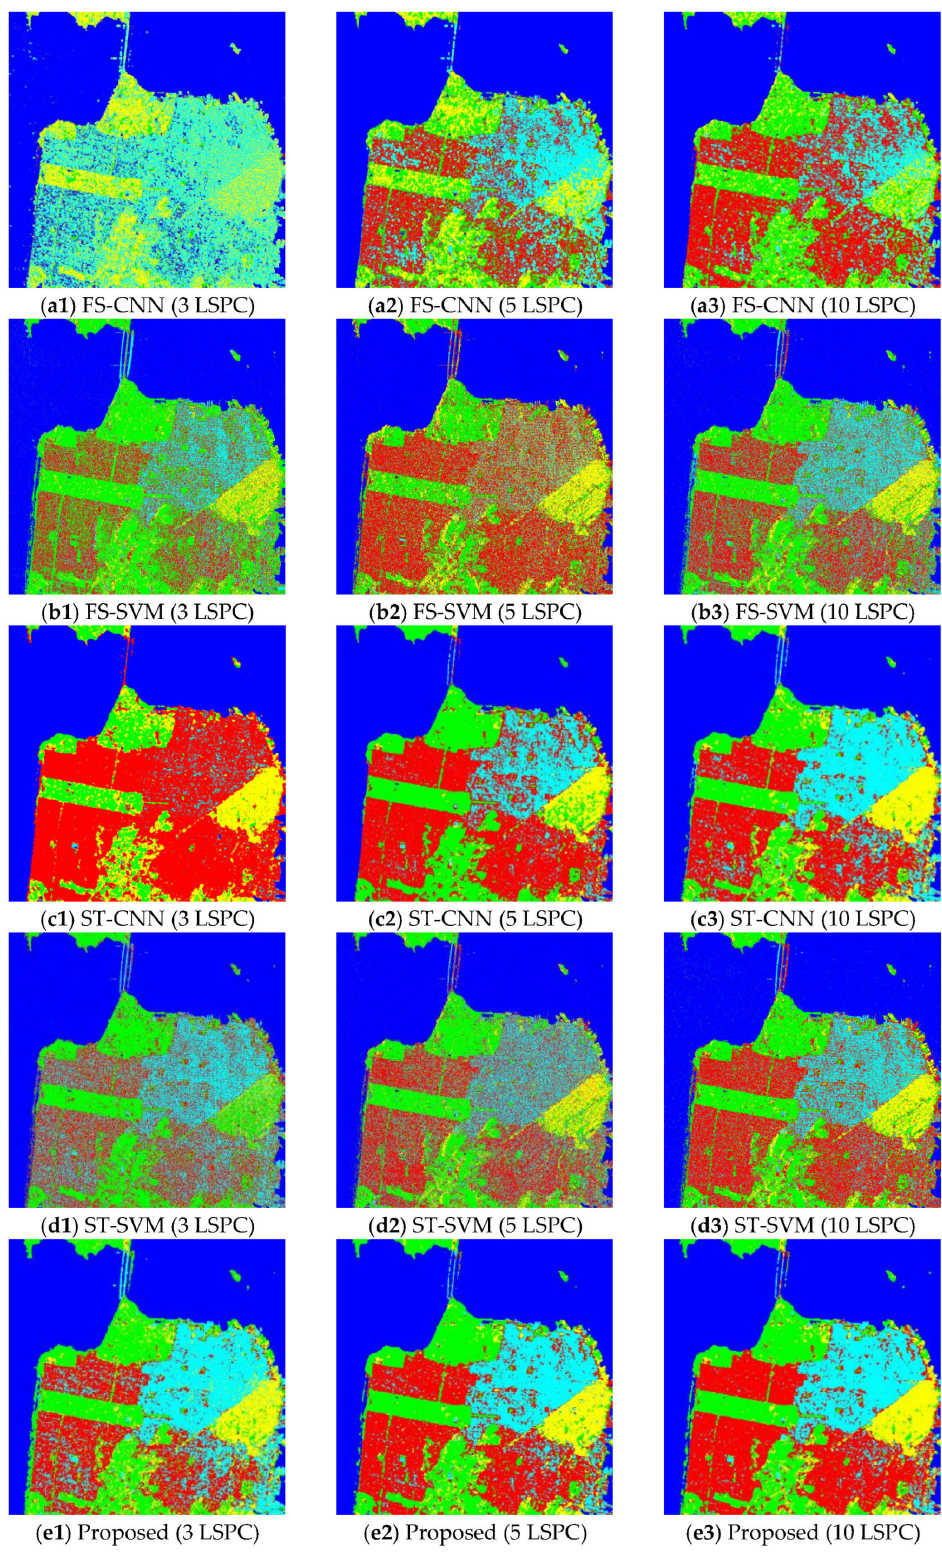
Figure 10. Classification maps of dataset 3 given by five methods with different sample sizes. The maps from up to down are given by FS-CNN, FS-SVM, ST-CNN, ST-SVM and the proposed methods, respectively, and those from left to right have 3, 5, and 10 LSPCs,